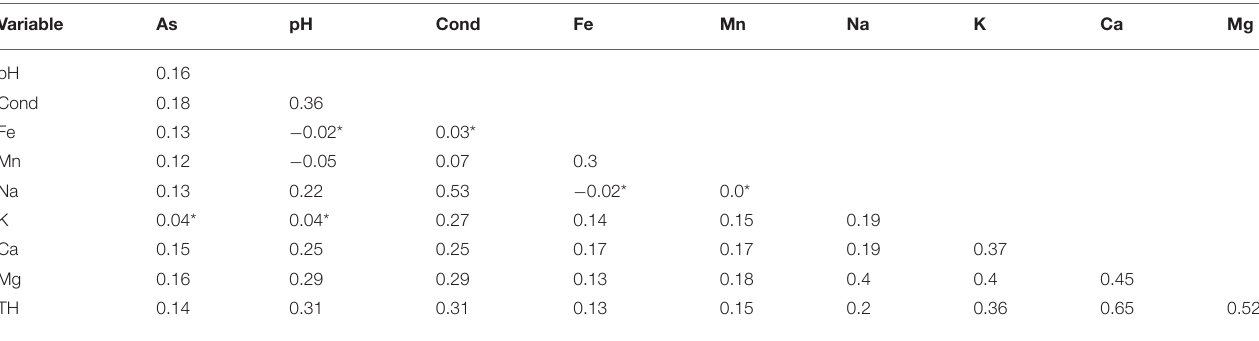
TABLE 4 | Correlation matrix of water quality parameters (all correlation coefficients denoted by * are not significant at the 5% significance level). Variable